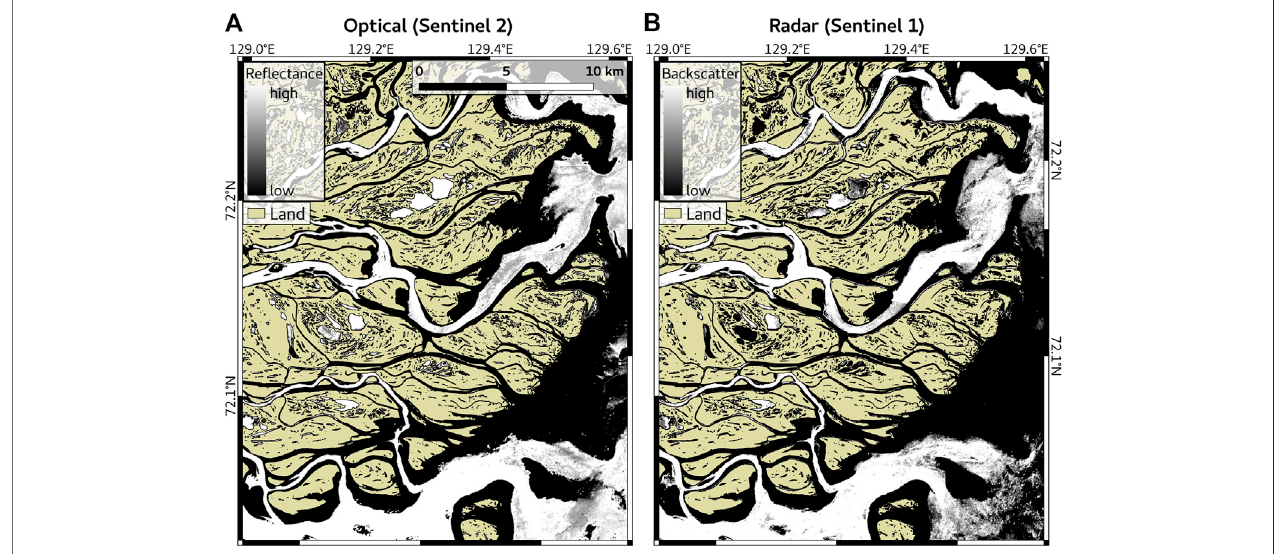
FIGURE2|A) OpticalSentinel-2satelliteimage(band8)fromJune8,2019and (B) SARSentinel-1wintermedianimage(2016 – 2020,December1toApril1)ofan area at the mouth of the Bykovskaya and Tro fi movskaya Channel in the eastern Lena River Delta. Serpentine ice over the deep parts of the channels is featured by high optical re fl ectance (A) and high SAR backscatter (B) . Yellow fi lling shows the upland areas.